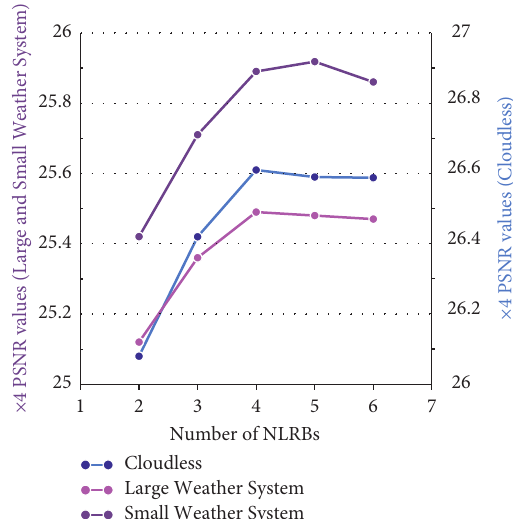
Figure 6: The average PSNR performance of NLRN on validation set with different parameter G (the total numbers of